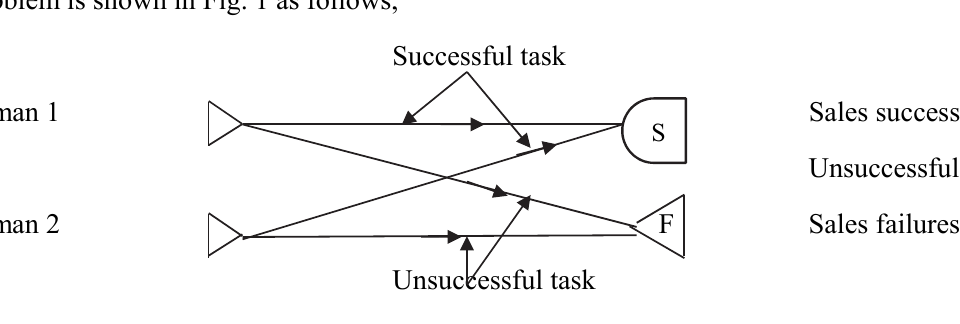
Fig. 1. A simple GERT